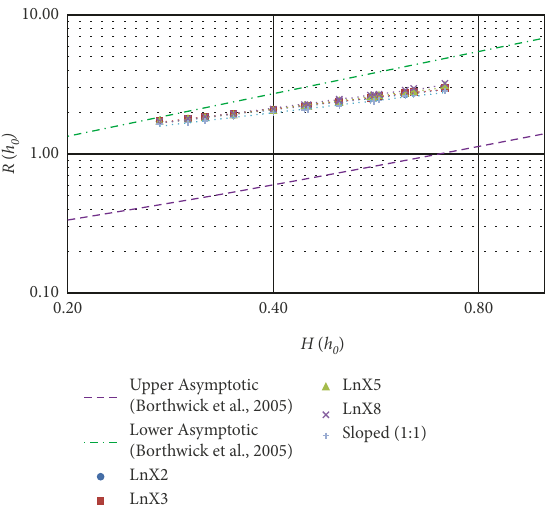
Figure 21: Comparison of normalized wave run-up versus nor- malized wave height for logarithmic and sloped